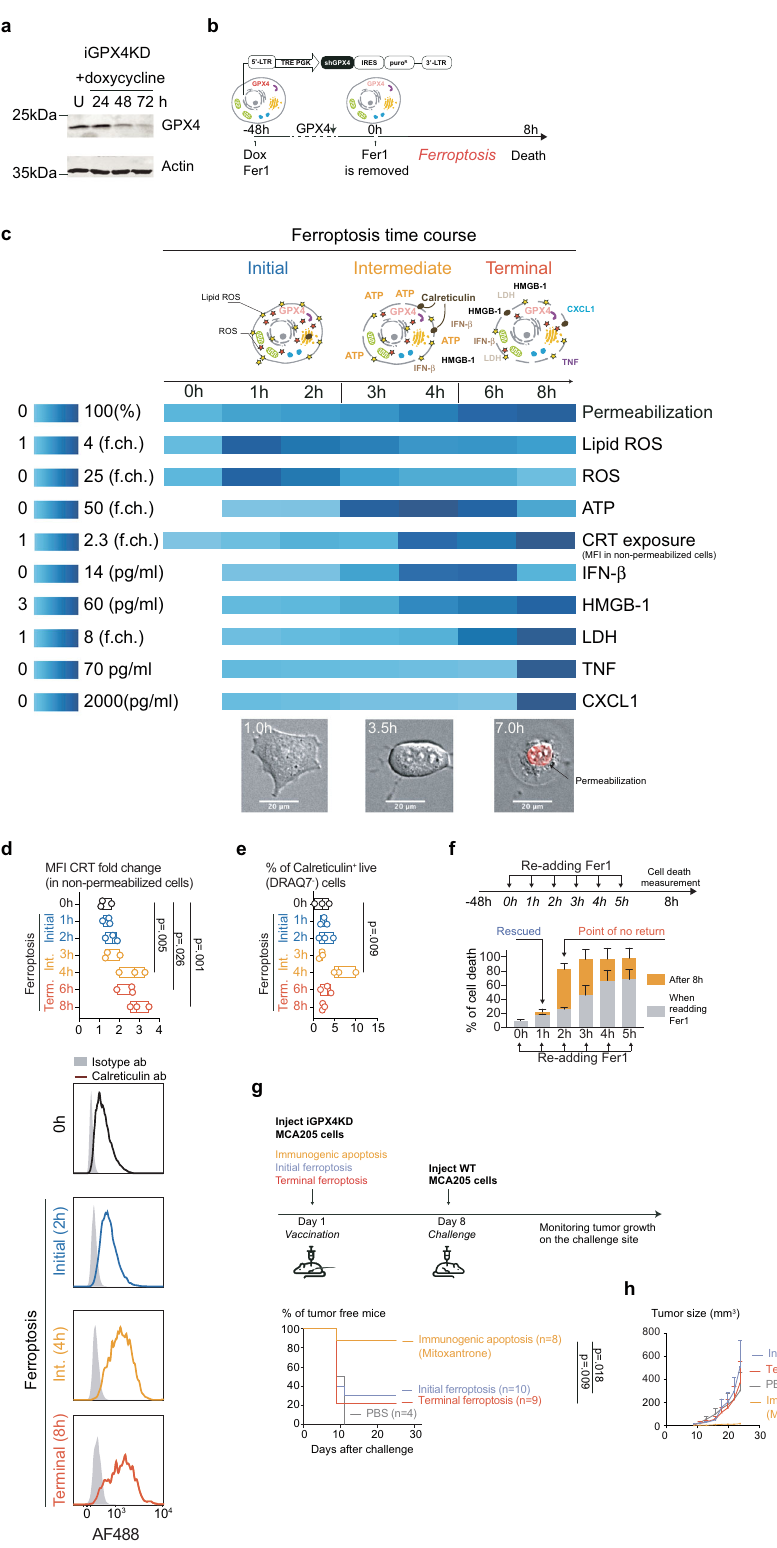
proliferation, differentiation, and in fl ammatory response (Fig. 4c) while at the same time upregulated programs related to migra- tion, due to the strong increase in chemokine gene signature. These data suggest that exposure to ferroptotic cancer cells negatively impacts the antigen-presenting features of DC at a transcriptional level.